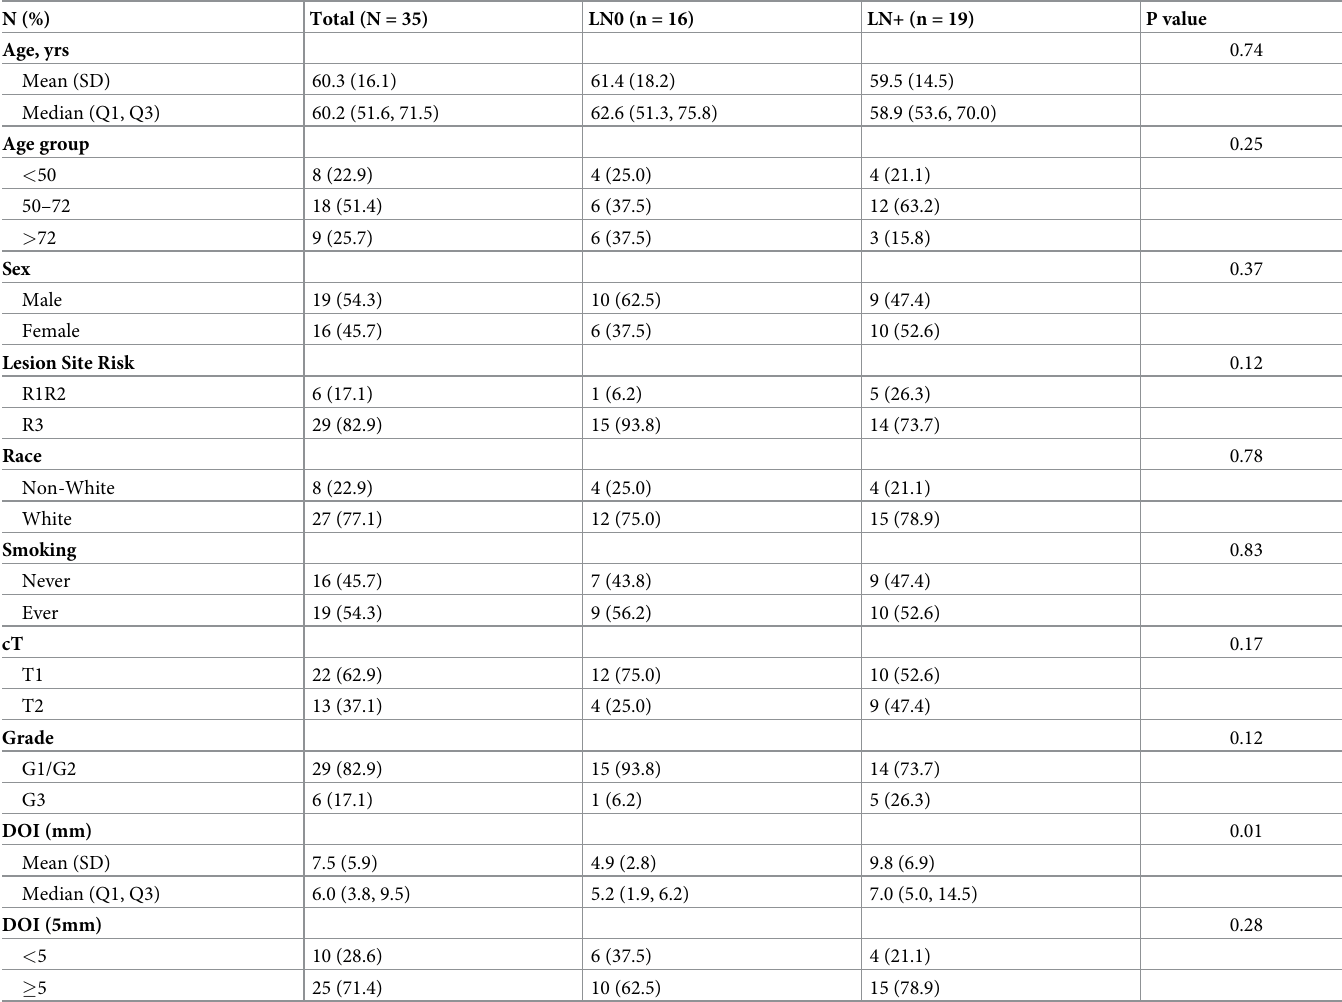
Table 1. Patient and clinical-pathological